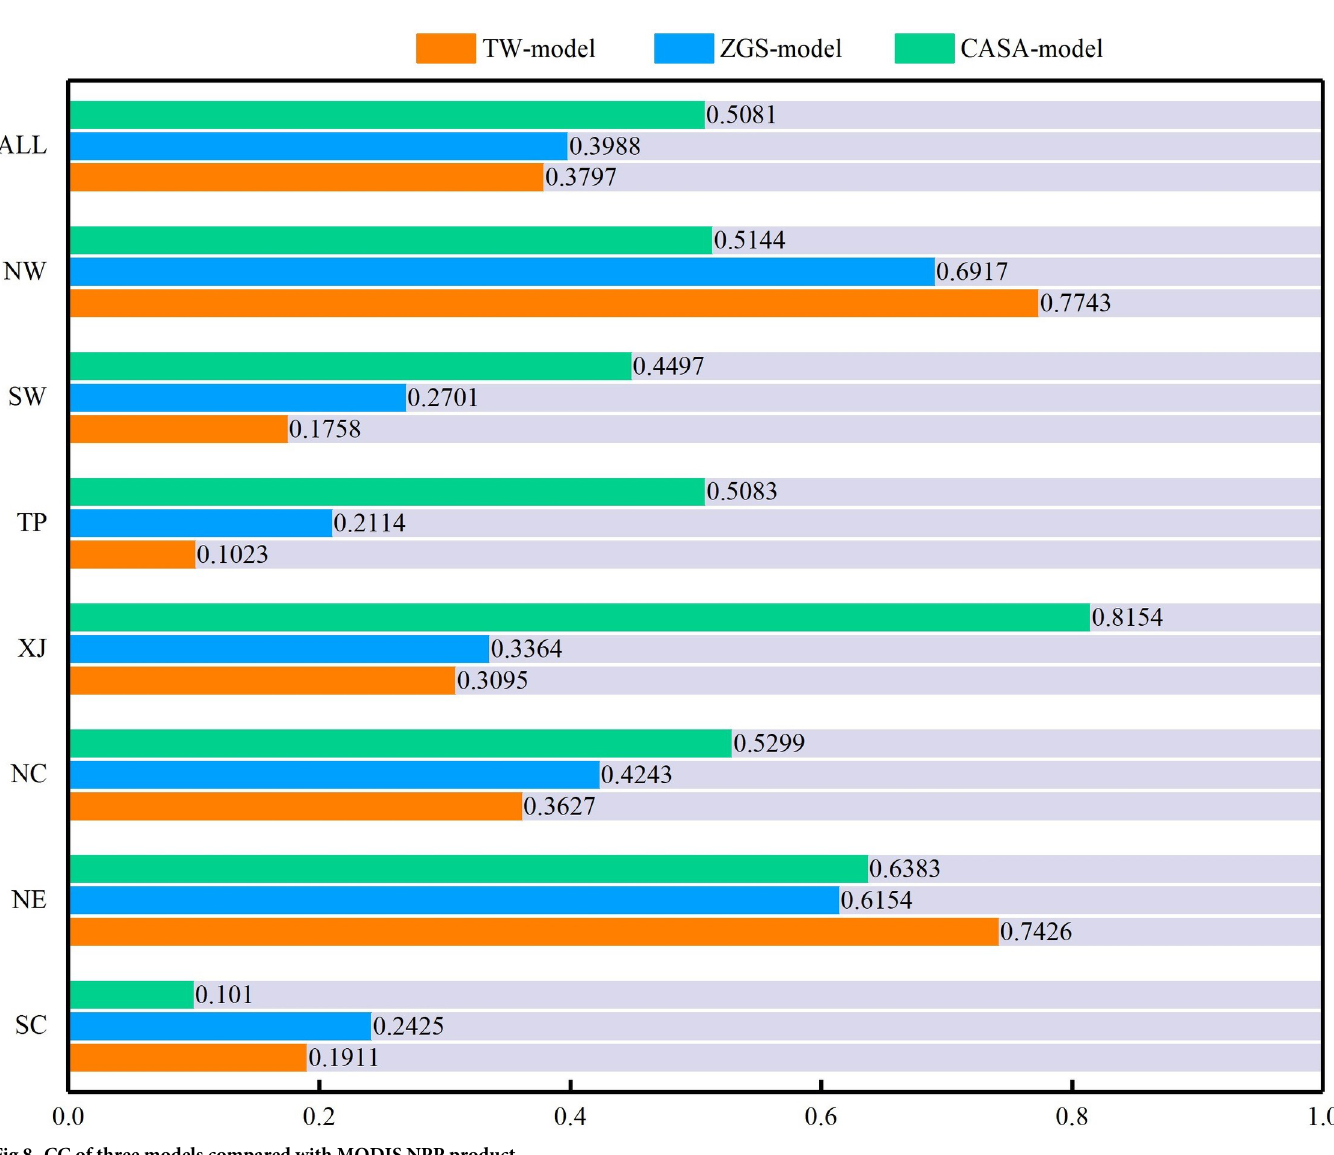
Fig 8. CC of three models compared with MODIS NPP